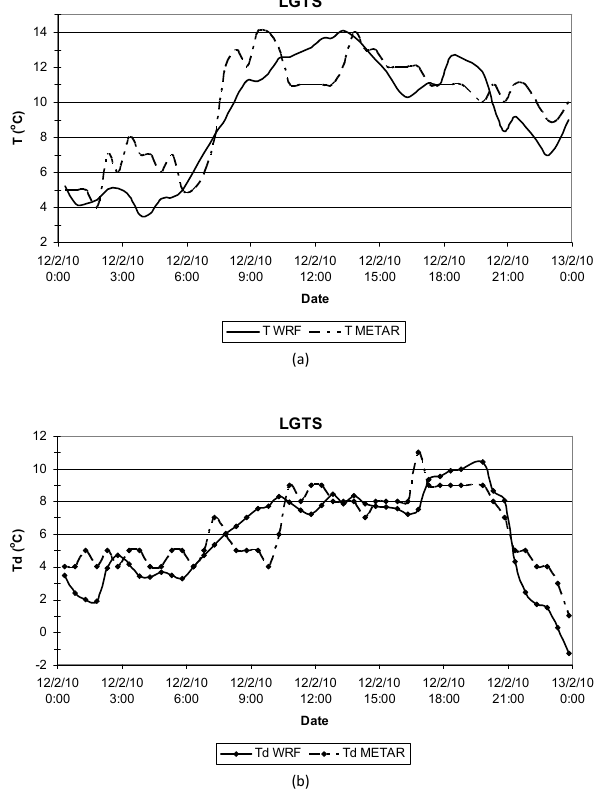
Figure 6: Time series of Temperature (a) and Dew-point Temperature (b) observations 2 (METAR) and WRF forecasts at LGTS (Time in UTC). 3 Figure 6. Time series of (a) Temperature and (b) Dew-point Tem- perature observations (METAR) and WRF forecasts at LGTS (Time in